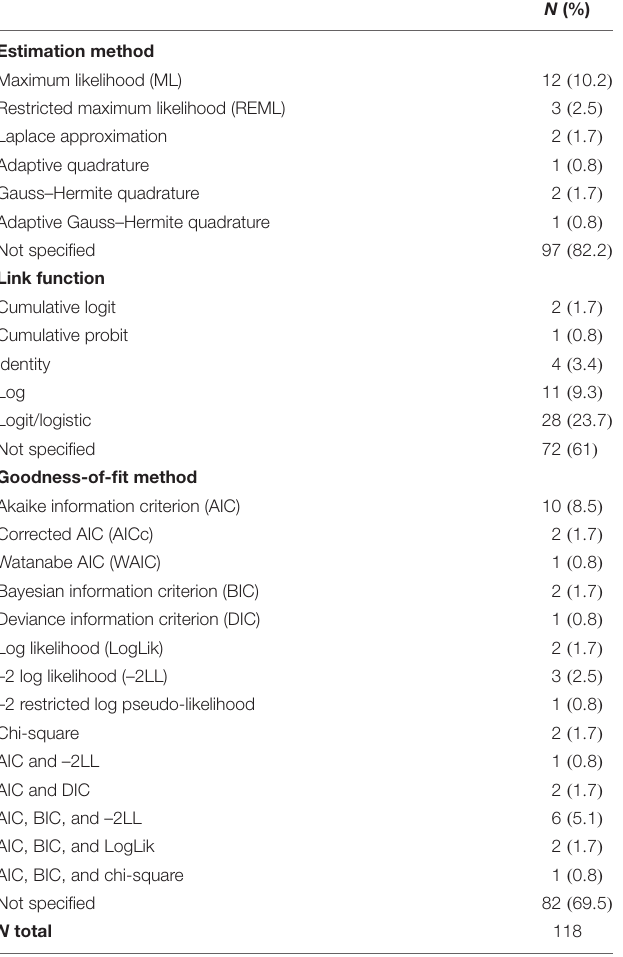
TABLE 4 | Statistical inference of fixed effects in the 118 GLMM N (%)